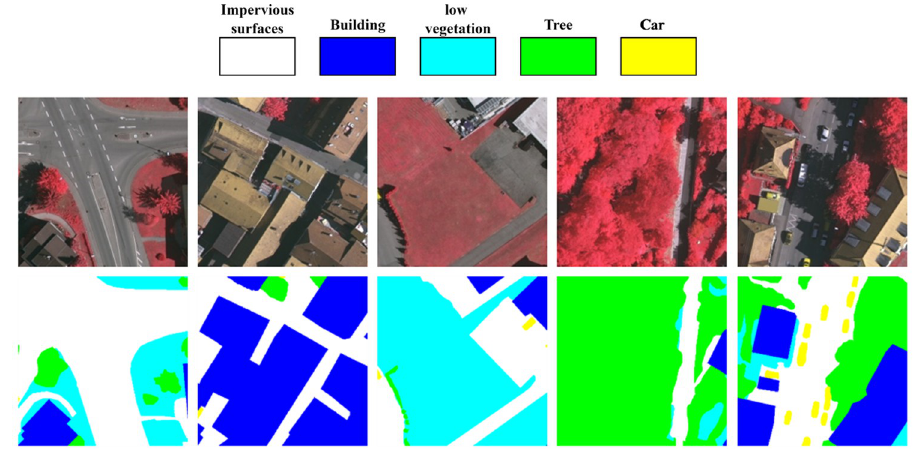
Fig 5. ISPRS Vaihingen dataset example. Reprinted from [17] under a CC BY license, with permission from [DGPF], original copyright [2010].